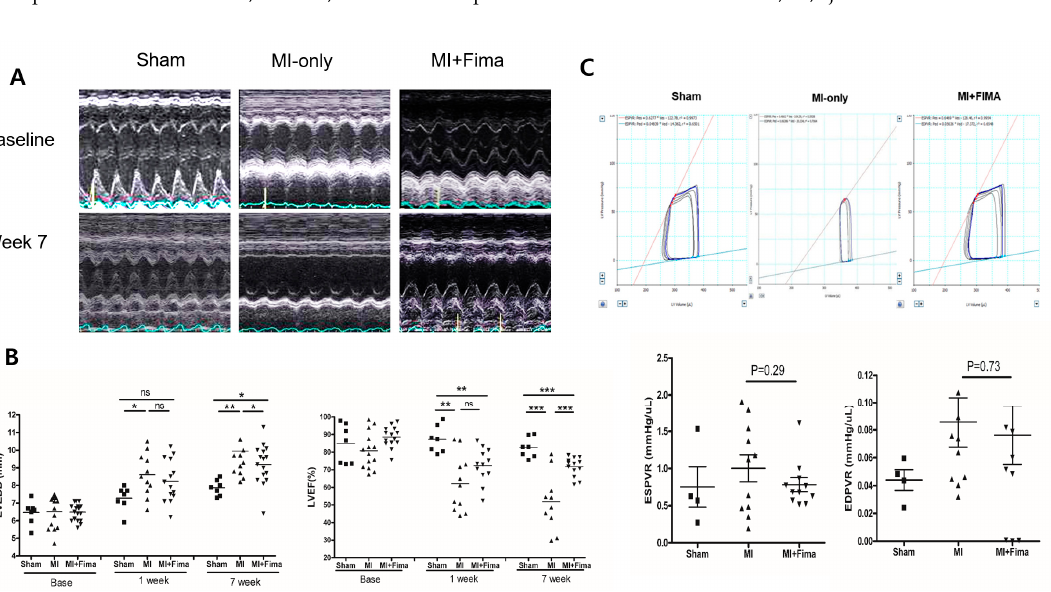
Figure 2. The anatomy and hemodynamics: ( A ) The chamber size measurement in M-mode, ( B ) the chamber size and ejection fraction of the rats during the experiment, and ( C ) the pressure–volume loops 7 weeks after MI. ■ , sham; ▲ , MI; ▼ , MI + Fima. The MI + Fima group showed a smaller left ventricular volume and larger end-systolic pressure–volume relation (end-systolic pressure–volume relation, red line) compared with the MI-only group. EDPVR, end-diastolic pressure–volume relation; EDP, endo-diastolic pressure; ESPVR, end-systolic pressure–volume relationship; Fima, fimasartan; MI, myocardial infarction; LVEDD, left ventricular end-diastolic diameter; LVEF, left ventricular ejection fraction. The P -values represent * P < 0.05, ** P < 0.01, and *** P < 0.001. The results are expressed as mean ± SEM (Standard Error